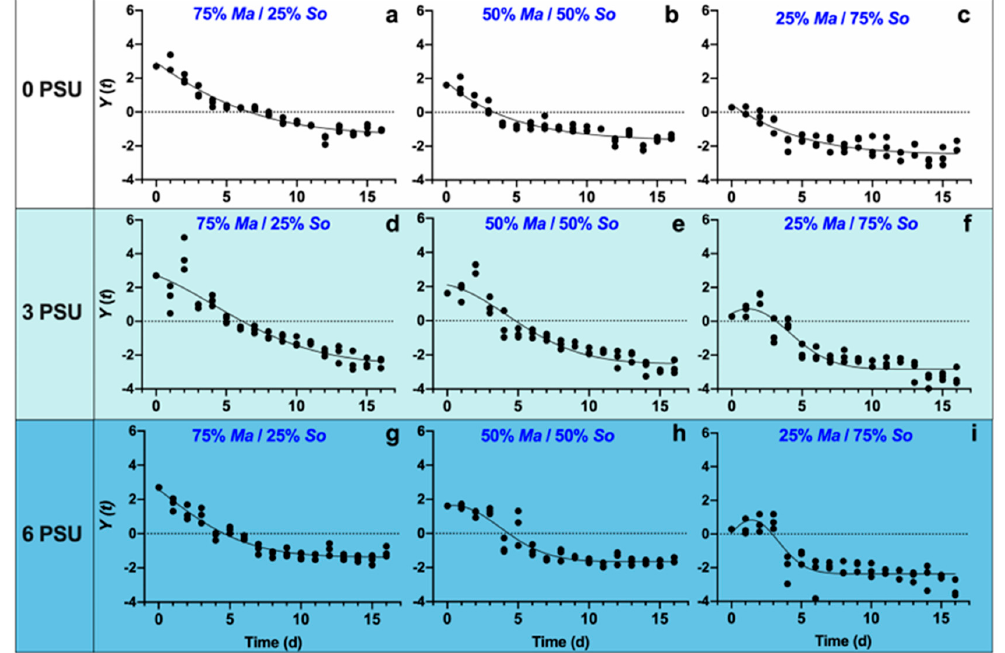
Figure 3. Displacement rates for M. aeruginosa against S. obliquus with different initial algal compo- sitions at different salinities (( a , d , g ): 75% Ma /25% So at 0, 3, 6; ( b , e , h ): 50% Ma /50% So at 0, 3, 6; ( c , f , i ): 25% Ma /75% So at 0, 3, 6).